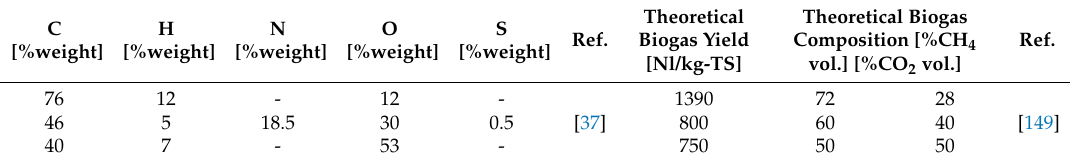
Table 2. Chemical composition of lipids, proteins, carbohydrates, theoretical biogas yield and biogas composition from lipids, proteins, and carbohydrates (LPCH) calculated using Buswell-Mueller [165] and Boyle [166]